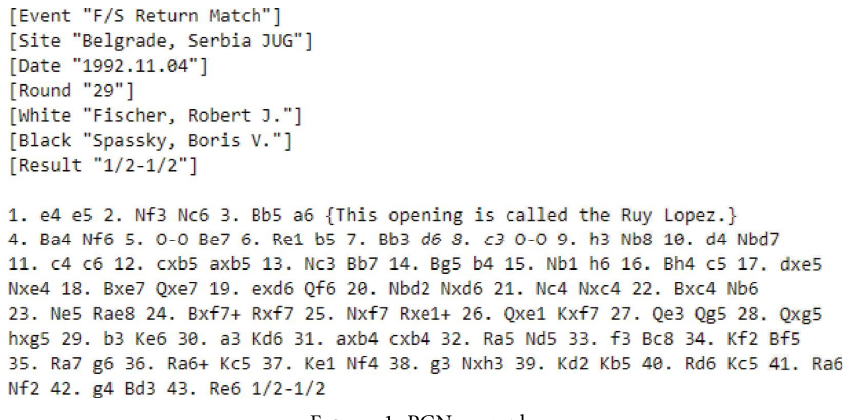
Figure 1: PGN example.